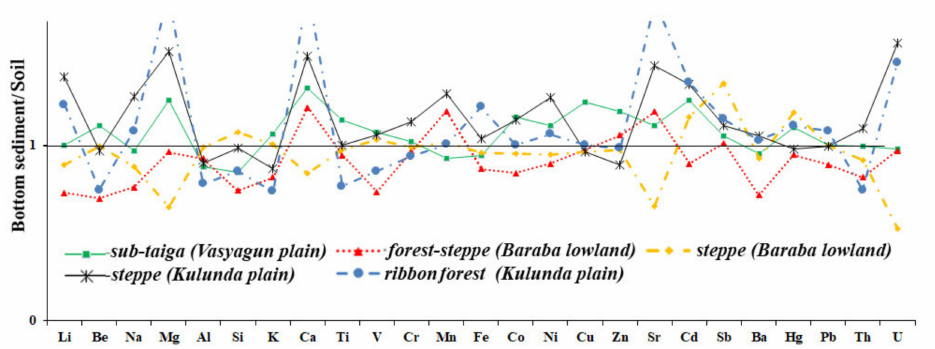
Figure 4. The multi-element spectrum of the average values of the studied elements for bottom sediments of lake systems in the different type of landscape of South of Western Siberia normalized to the values of the soils of the catchment area of the lakes (according to our